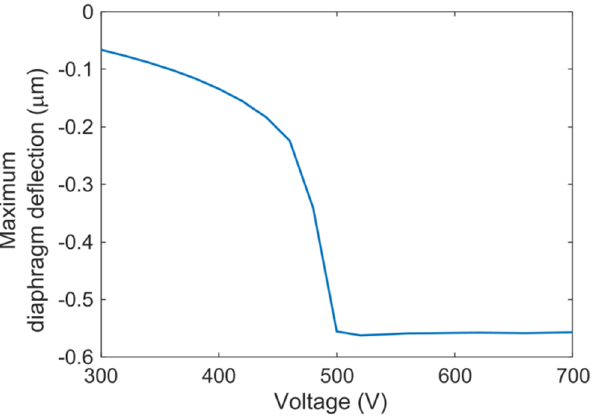
Figure 9. 3D electromechanical finite element analysis (FEA) results showing the CMUT diaphragm deflection as a function of direct current (DC) bias [21].